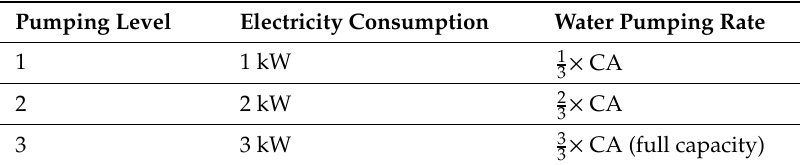
Table 1. Water pump motor consumption and capacity levels (CA = capacity).